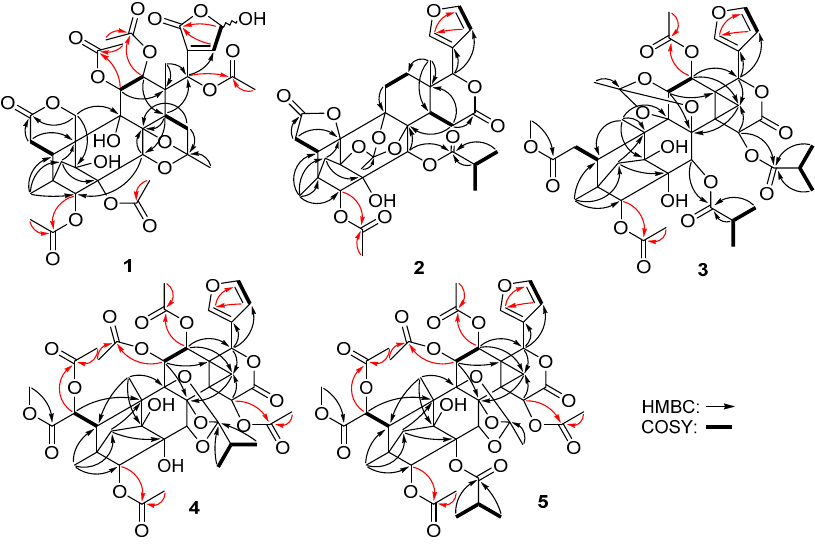
Figure 2. Key HMBC and 1 H- 1 H COSY correlations for compounds 1 – 5 .